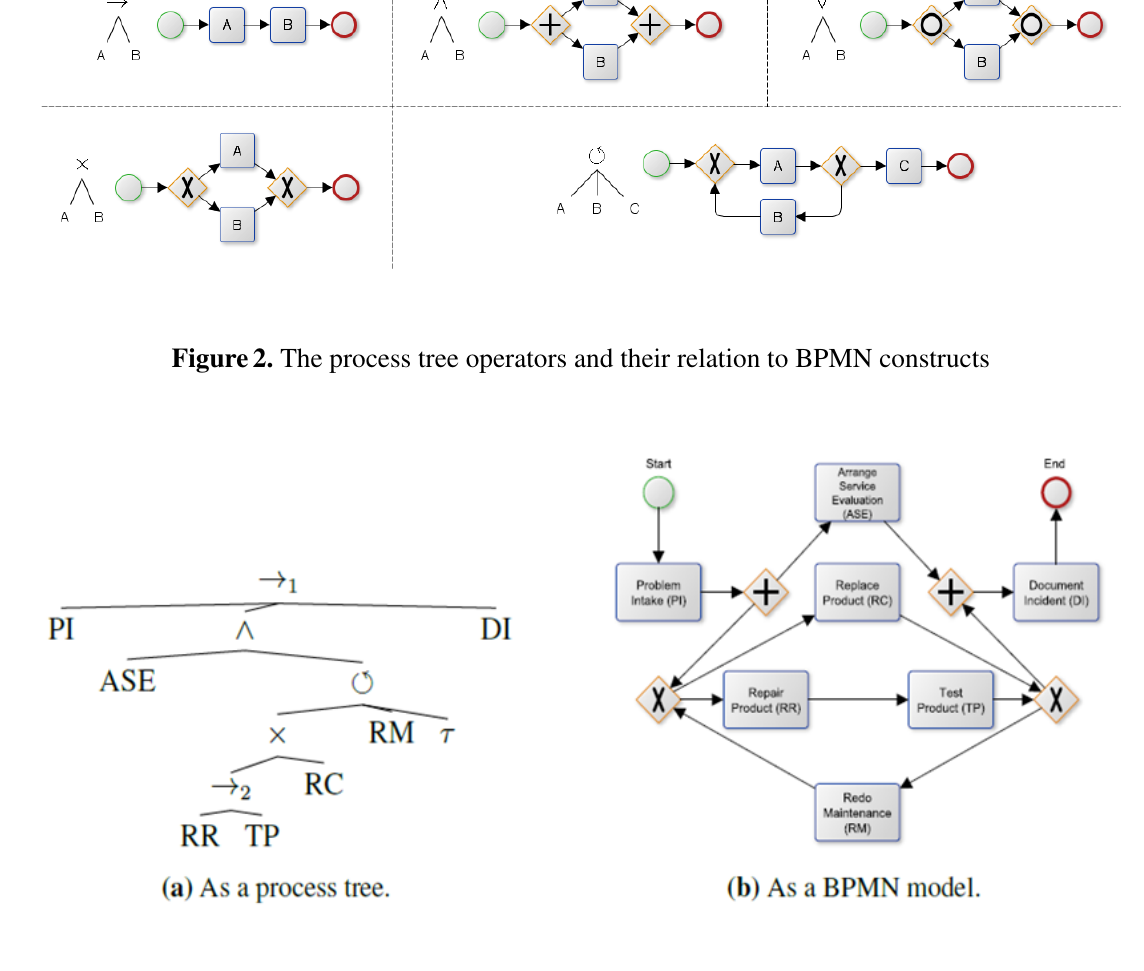
Figure 3. A process model for a simple hardware maintenance